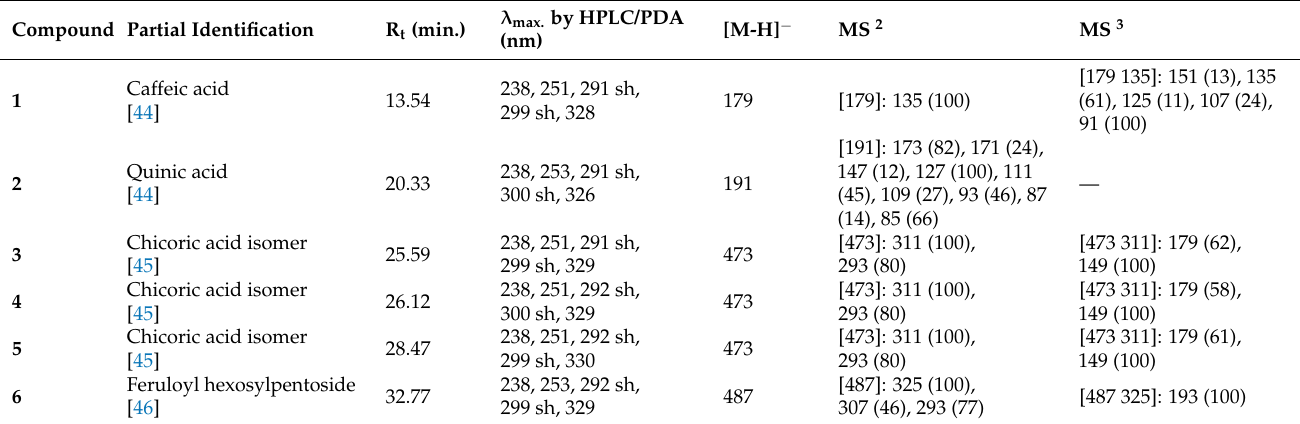
Table 5. Compounds identified in Cv 70% ethanol extract by HPLC-PDA-ESI/MS n .